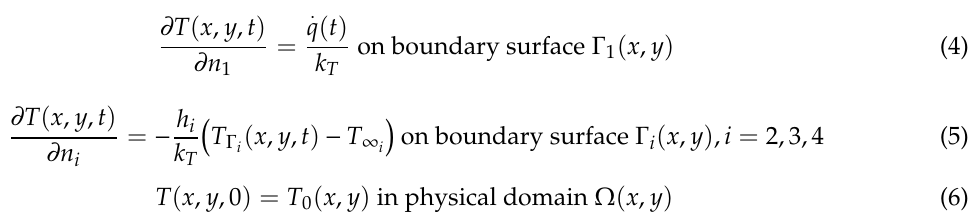
Figure 1. Arbitrarily shaped two dimensional heat-conducting body (physical domain) subjected to a timewise varying heat flux q ( t ) on surface Γ 1 and convective heat transfer on surfaces Γ i , i = 2,3,4 ( a ) and the corresponding computational domain ( b ).